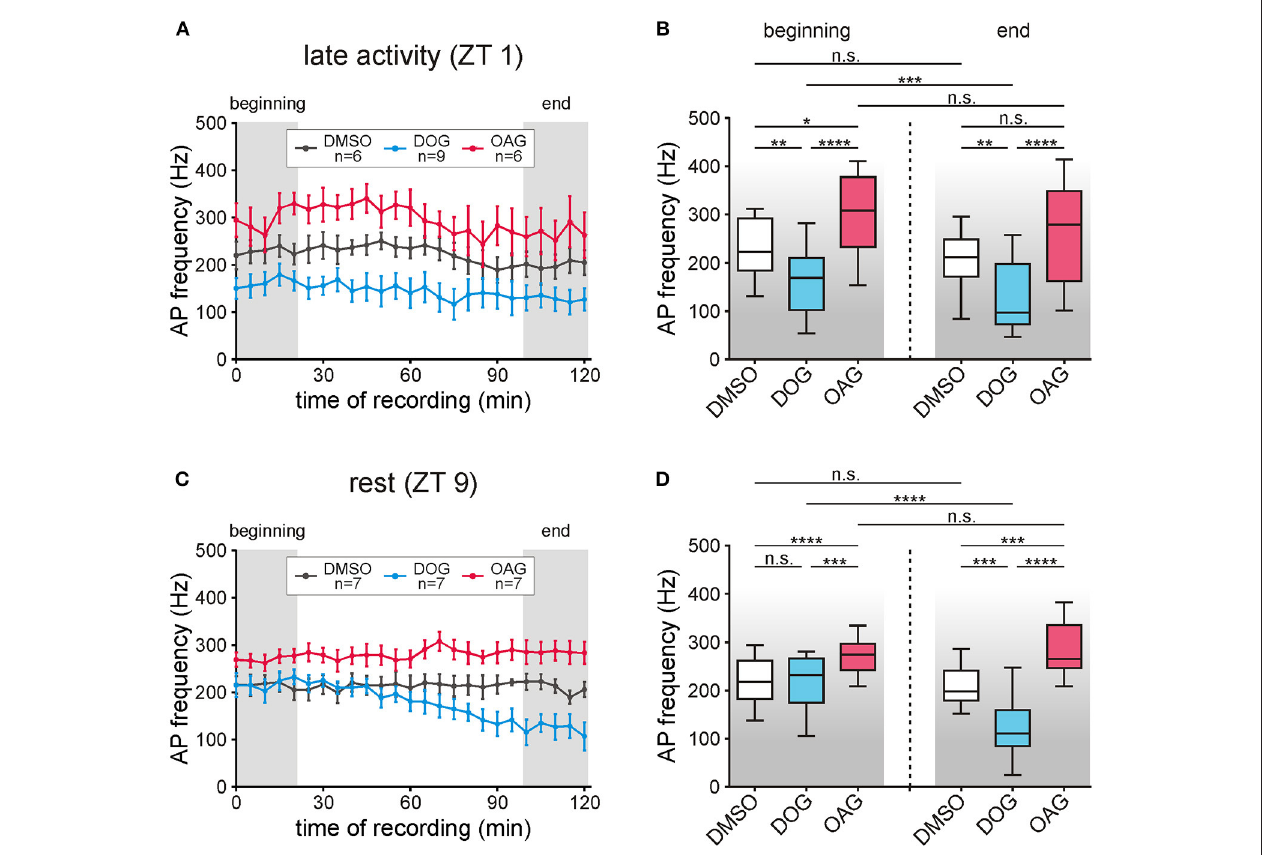
FIGURE 4 | The phasic pheromone response was increased by OAG but decreased by DOG. (A,B) The phasic pheromone response ( = frequency of the first 6 bombykal (BAL)-dependent action potentials (APs)) was stable in recordings during the late activity phase (ZT 1) for controls as well as for application of 100 µ M OAG. However, with OAG phasic pheromone responses were significantly elevated in comparison to the controls at the beginning- and at the end of the recordings. Infusion of 100 µ M DOG significantly reduced the phasic pheromone response as compared to controls already during the first 20min and further decreased it toward the end of the recordings. (C,D) In the first hour of recordings during the animals’ resting phase (ZT 9) application of 100 µ M OAG significantly increased the AP frequencies while 100 µ M DOG had no effect. In the second hour of the recordings DOG continuously decreased the frequency of the first 6 BAL-dependent APs while in controls as well as with 100 µ M OAG the levels were unchanged (for exact P -values see Table 3 ; for mean values ± SEM see S3. n.s. = not significant; * P < 0.05; ** P < 0.01; *** P < 0.001; **** P < 0.0001; Wilcoxon test, Mann-Whitney test or Kruskal-Wallis test with Dunn’s post-hoc test for multiple comparison).